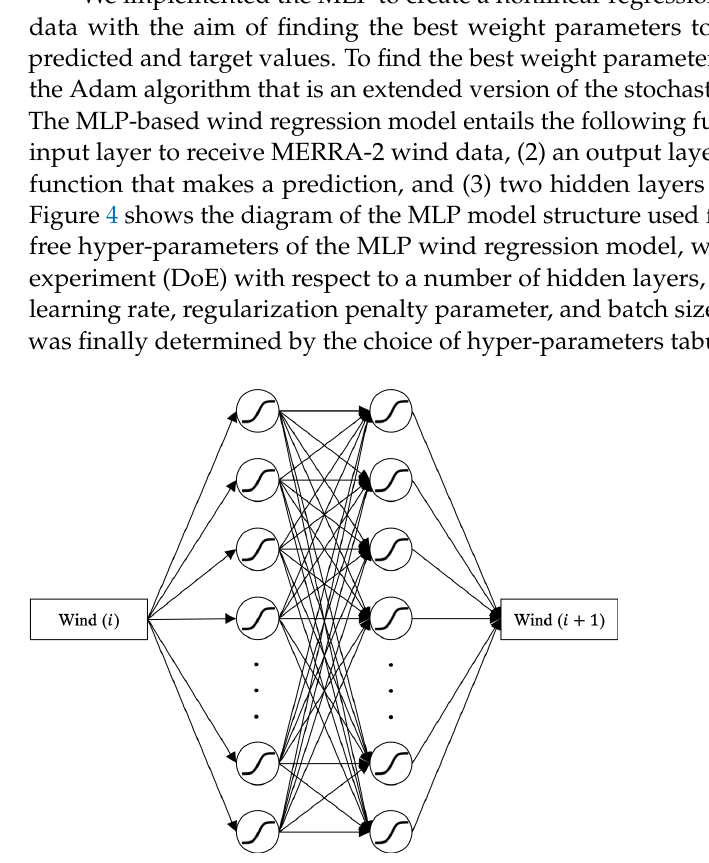
Figure 4. Diagram of the MLP structure used in this